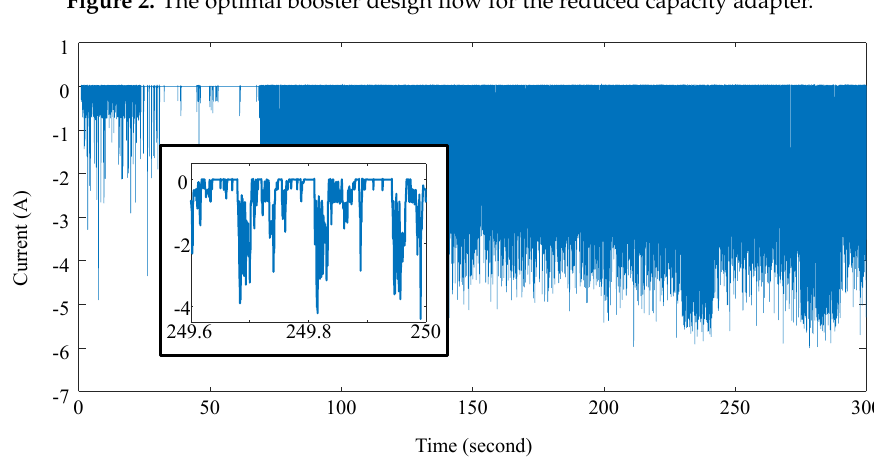
Figure 2. The optimal booster design flow for the reduced capacity adapter.